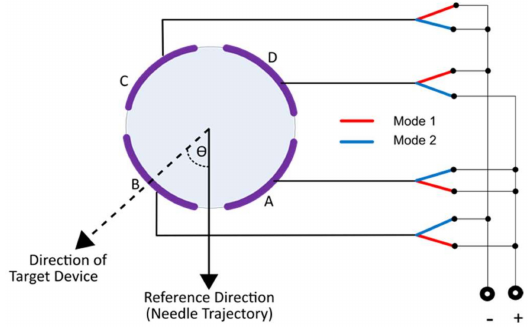
Figure 2. Connection to the source